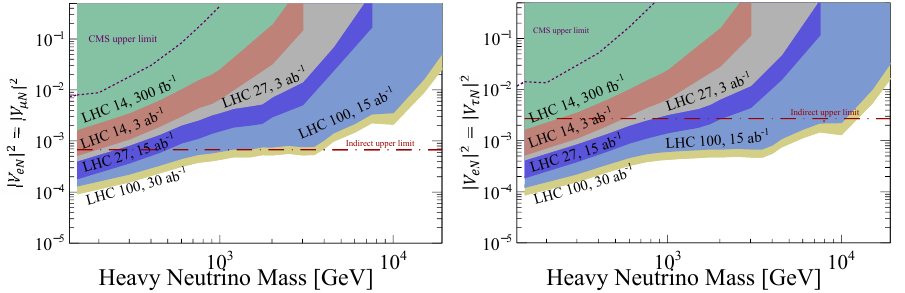
3 10 Figure 11. Sensitivities of heavy neutrino mass m N and the heavy-light neutrino mixing | V | 2 = | V | 2 ( left ) or | V | 2 = | V | 2 ( right ), at future LHC 14 TeV with luminosities of 300 fb − 1 eN eN µ N µ N and 3 ab − 1 , LHC 27 TeV with 3 ab − 1 and 15 ab − 1 , and 100 TeV collider with 15 ab − 1 and 30 ab − 1 . Regions above the short dashed lines are excluded by CMS data, and the dot-dashed horizontal lines indicate the indirect limit from current EWPD data. See text for more details. Figure from Ref. [124]. At the GeV-scale, the limits on the neutrino mass m N and | V α N | 2 will be mostly from the high-precision LFV measurements below